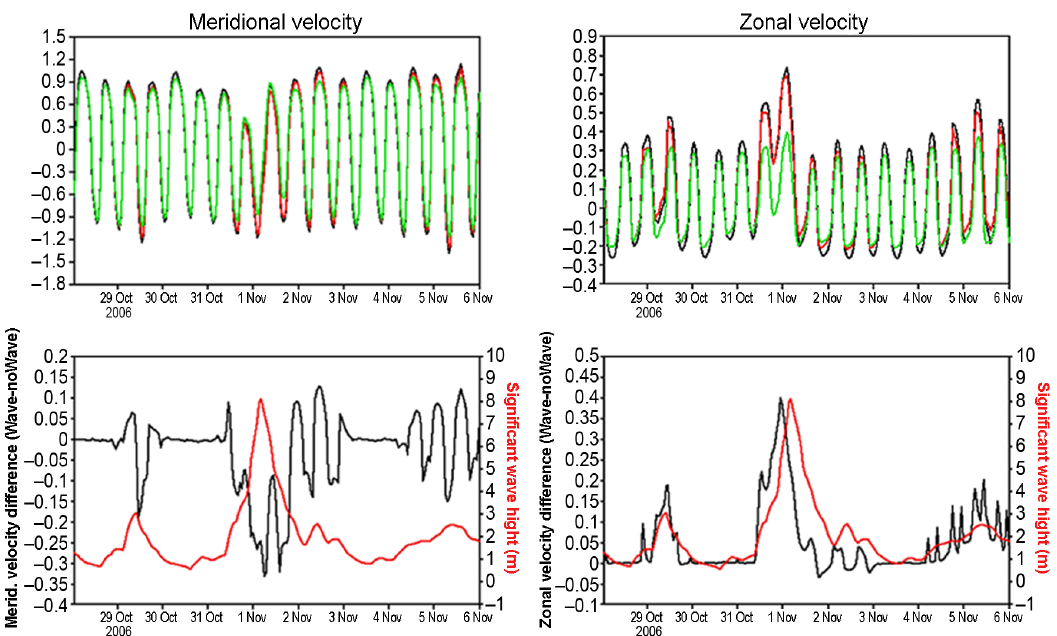
Figure 8. Top: meridional (left) and zonal (right) velocity time series (ms − 1 ) on station W1 (see Fig. 1 for its location) from measurements (black line), coupled wave–circulation model (red line) and hydrodynamic-only model (green line) during storm Britta. Bottom: differences between the coupled and non-coupled model simulations of meridional (left) and zonal (right) velocity (ms − 1 ) (black line) and significant wave height (m) (red line).